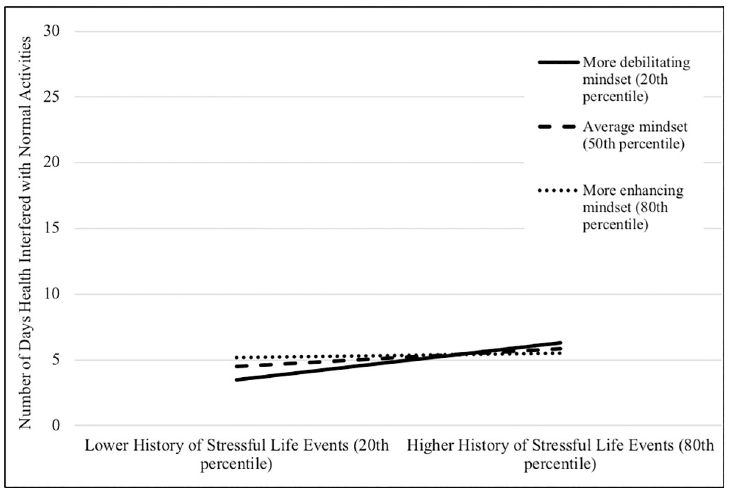
Fig 3. Graphical representation of interaction between history of stressful life events and general stress mindset predicting days health interfered with normal activity.